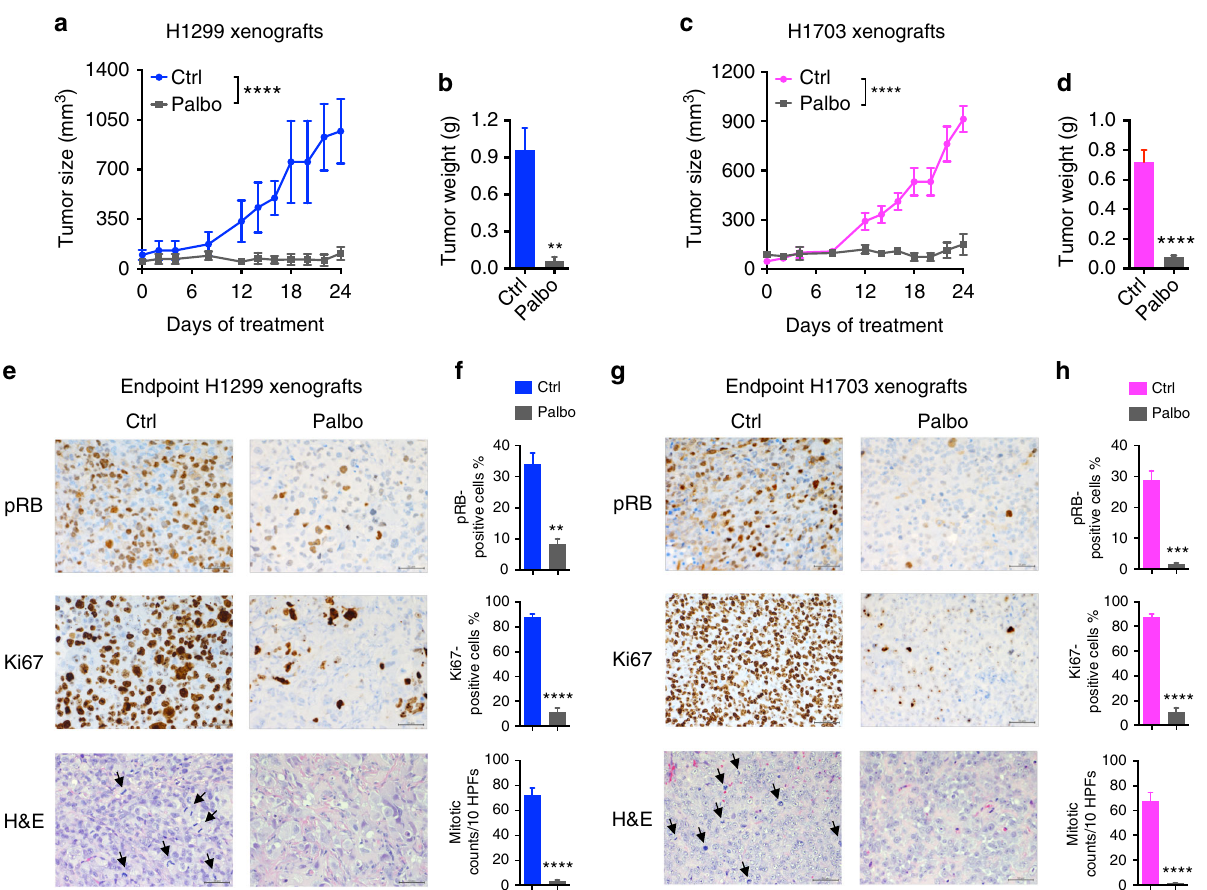
Fig. 2 Palbociclib is effective against SMARCA4-de fi cient non-small cell lung cancer (NSCLC) tumor growth in vivo. Palbociclib inhibits tumor growth in xenograft models of H1299 ( a , b , e , f ) and H1703 ( c , d , g , h ). a , c Tumor size from day 0 of treatment in H1299 ( a , n = 4 per group) and H1703 ( c , n = 8 for vehicle, n = 7 for palbociclib; 150 mg kg − 1 ) models. Error bars represent mean ± standard error of mean (s.e.m.); two-way analysis of variance (ANOVA), **** p < 0.0001. b , d Final tumor weight measured after surgery in H1299 ( b ) and H1703 ( d ) models. Two-tailed t -test, ** p < 0.01, **** p < 0.0001. e – h Palbociclib treatment resulted in suppression of RB phosphorylation, Ki67 expression and mitotic index in xenograft tumors of the trial endpoints. Representative images of Immunohistochemistry (IHC) (p-RB, Ki67) and hematoxylin and eosin (H&E) analysis of H1299 ( e ) and H1703 ( g ) xenograft tumor tissues. Bar 50 µ m; black arrows point to mitotic active cells as examples. f , h Quanti fi cations of p-RB, Ki67 and mitotic count of H1299 ( f , n = 3) and H1703 ( h , n = 4). Two-tailed t -test, ** p < 0.01, *** p < 0.001, **** p <